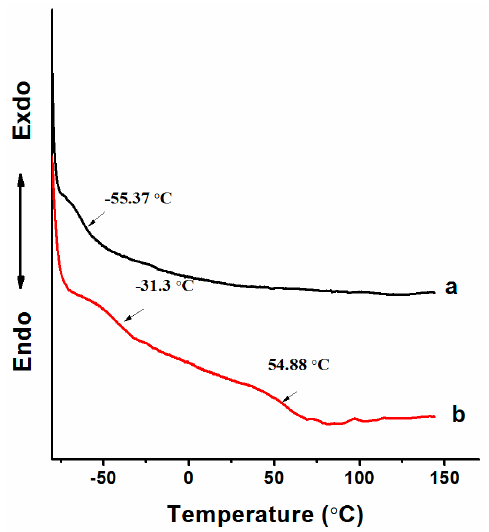
Figure 8. DSC thermograms of the hydroxyl-terminated PBA (a) and the PBA-based PUD (b).